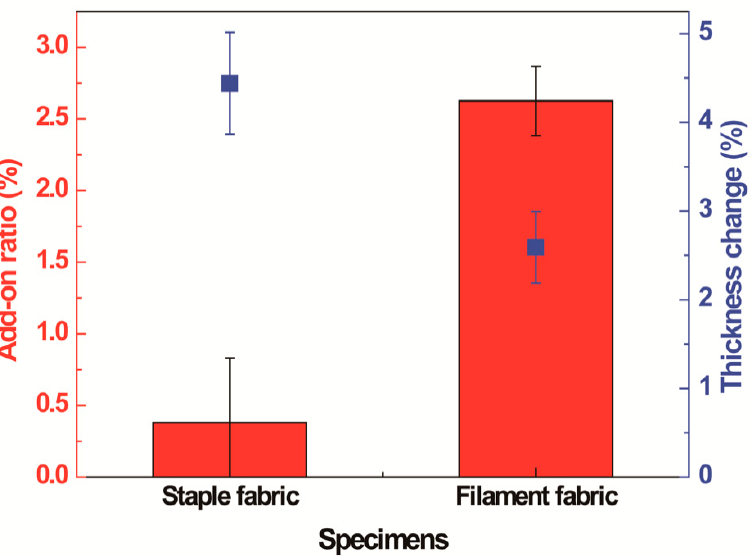
Figure 2. Change in the add-on ratio and thickness of staple fabric and filament fabric after 1 v / v % PDMS coating for 1 min (P1T1).